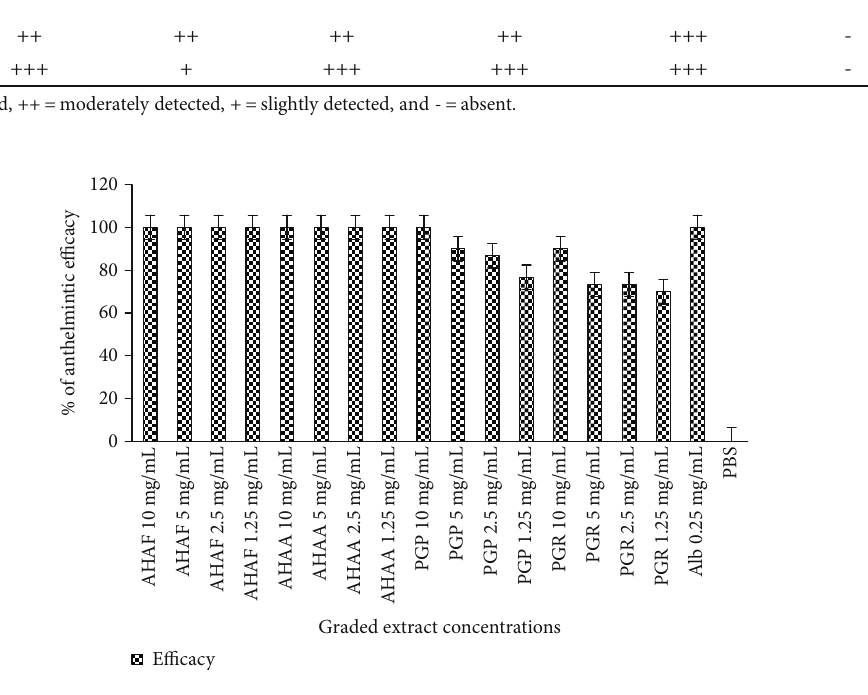
Figure 1: Relative nematocidal e ffi cacy of graded concentration of crude extracts of A . herba-alba and P . granatum . AHAF: A . herba-alba fl ower part, AHAA: A . herba-alba aerial part, PGP: P. granatum peel part, PGR : P . granatum root part, Alb: albendazole, PBS: phosphate bu ff er